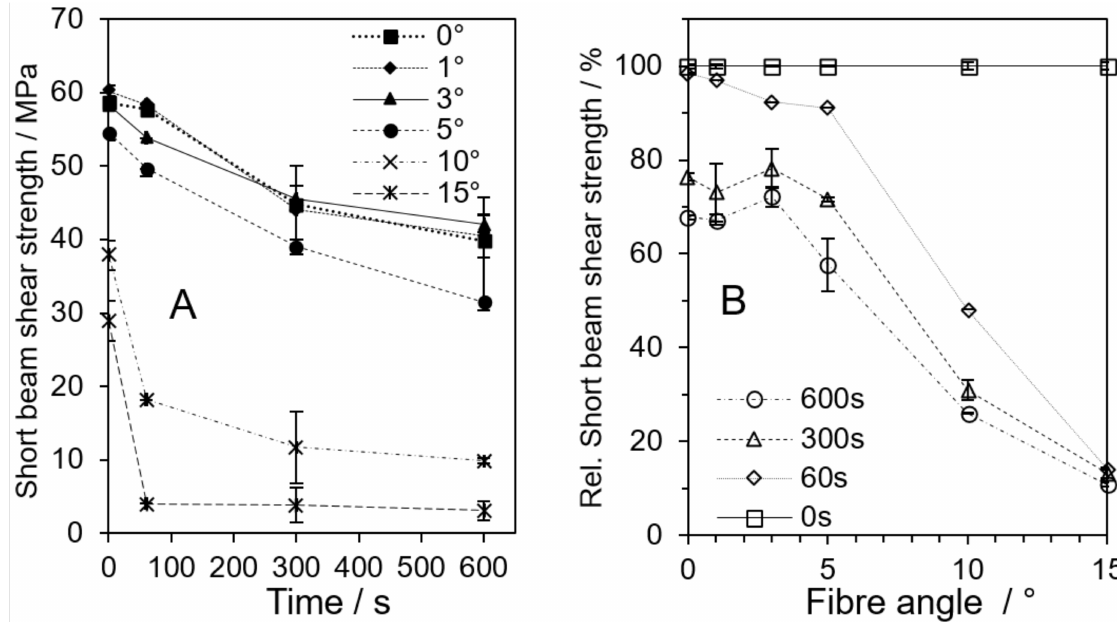
Figure 18. Short beam shear strength of samples after hot-air treatment. ( A ): dependent on loading time; ( B ): each sample related to the corresponding sample with the same out-of-plane fibre angle but without thermal treatment (0 s).